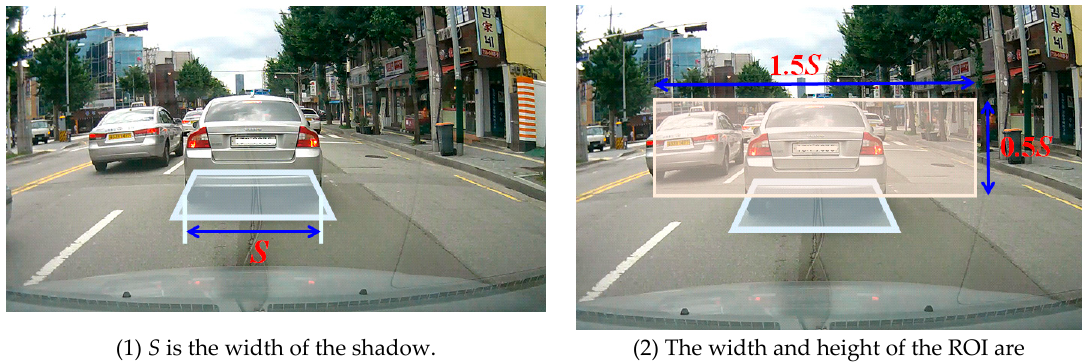
Figure 5. Region of interest (ROI) setting when car shadow is detected.